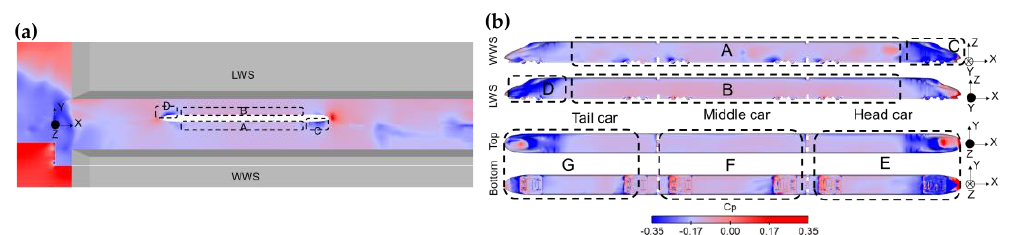
Figure 15. Pressure distribution at t * = 94: ( a ) top view at a height of 0.5 h and ( b ) train surface.